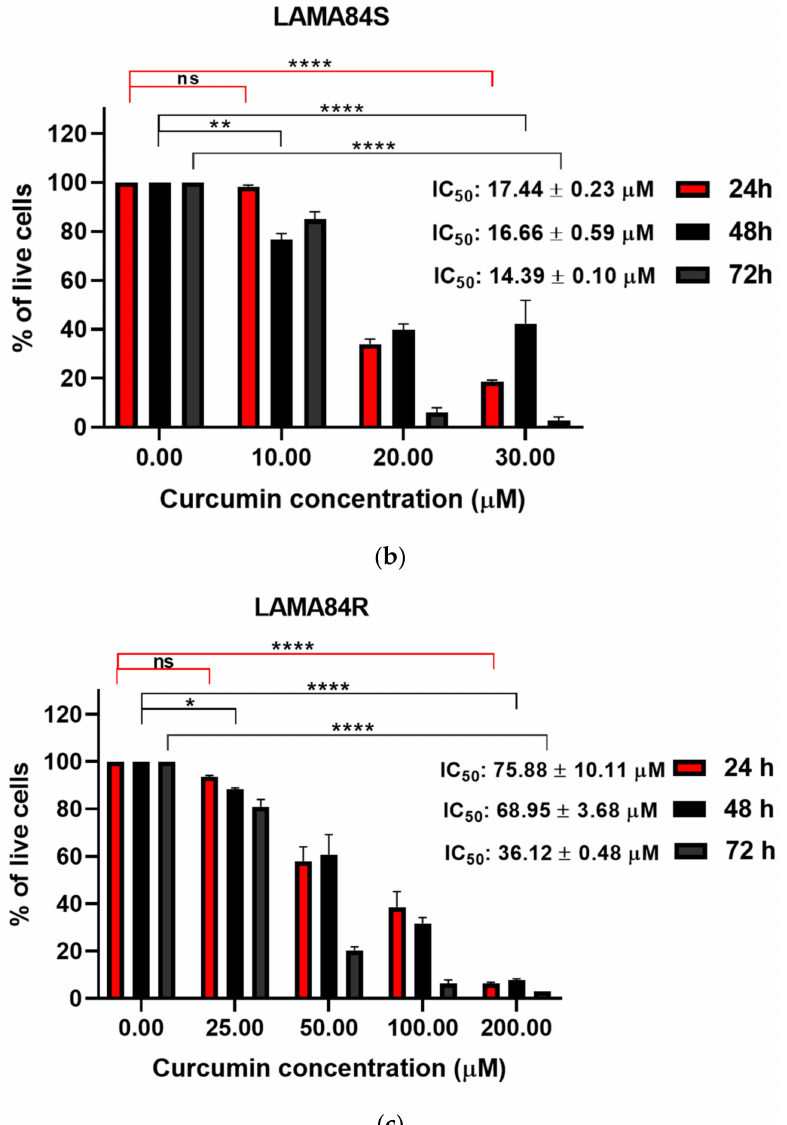
Figure 3. Time- and dose-dependent effects of curcumin on cell death of K562 ( a ), LAMA84S ( b ), and LAMA84R ( c ) cell lines evaluated through trypan blue exclusion assay. The mean ± standard deviations are shown. The results were obtained from at least three independent experiments. ns –